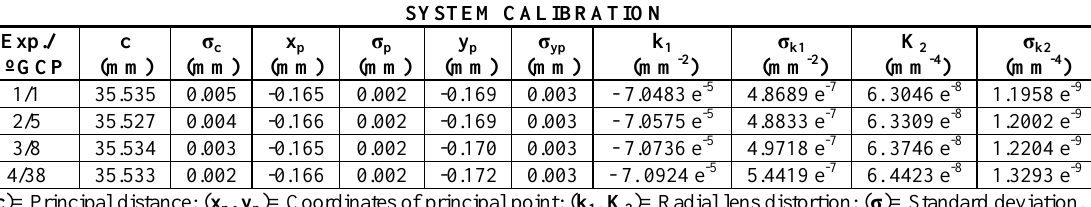
Table 3. The interior orientation parameters (IOP) computed in the “system calibration” that were significant on the variance- covariance